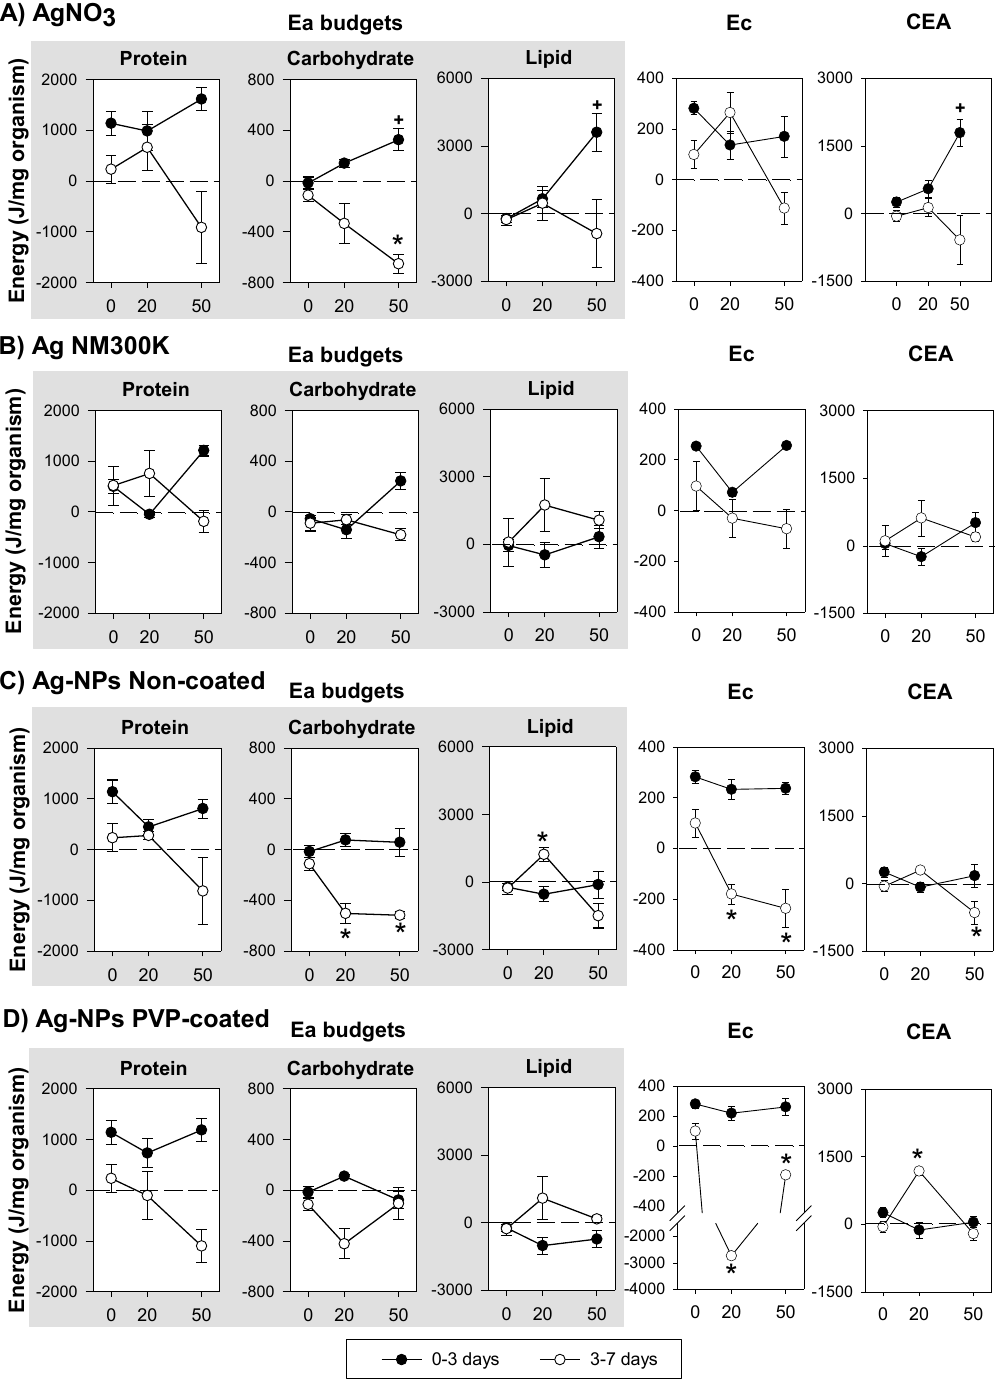
Figure 4. Effects of the reproduction effect concentrations (EC 20 and EC 50 ) of ( A ) silver nitrate—AgNO 3 ; ( B ) dispersed silver nanoparticles—Ag NM300K; ( C ) Non-coated silver nanoparticles—Ag-NPs Non-coated; and ( D ) PVP-coated silver nanoparticles—Ag-NPs PVP-coated, on the Energy available budgets (Ea: in terms of protein, carbohydrate and lipid budgets), Energy consumption (Ec) and Cellular Energy Allocation (CEA) in Enchytraeus crypticus , over periods of exposure (0–3 and 3–7 days). Results are expressed as average ± standard error. ⁺ , * Dunnett’s test, p < 0.05, for differences between EC x and control within 0–3 days ( ⁺ ) and 3–7 days ( * ). 0: Control, 20: EC 20 , 50: EC 50